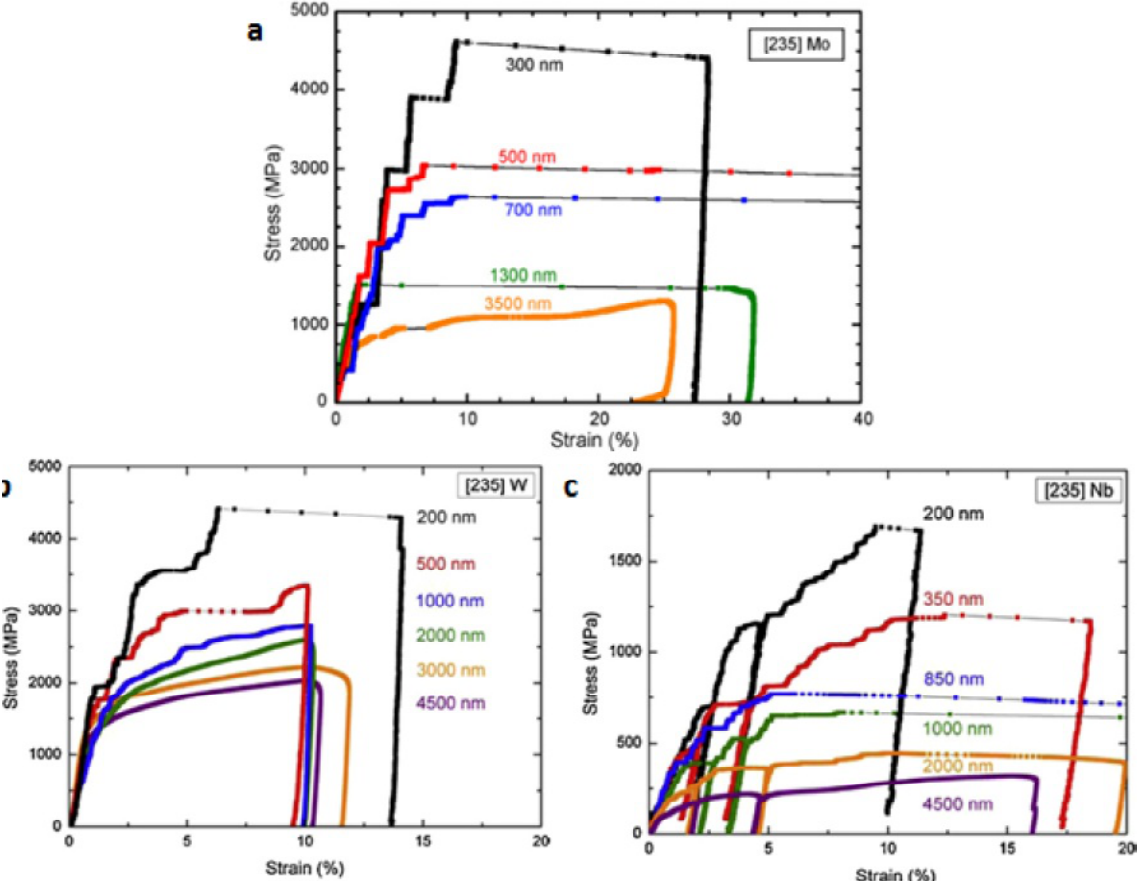
Fig. 24. Typical compressive stress–strain curves of [235] oriented (a) Mo, (b) W (c) Nb pillars [164,166]. Reprinted with permission from Schneider AS, Clark BG, Frick CP, Gruber PA, Arzt E. 2009. Effect of